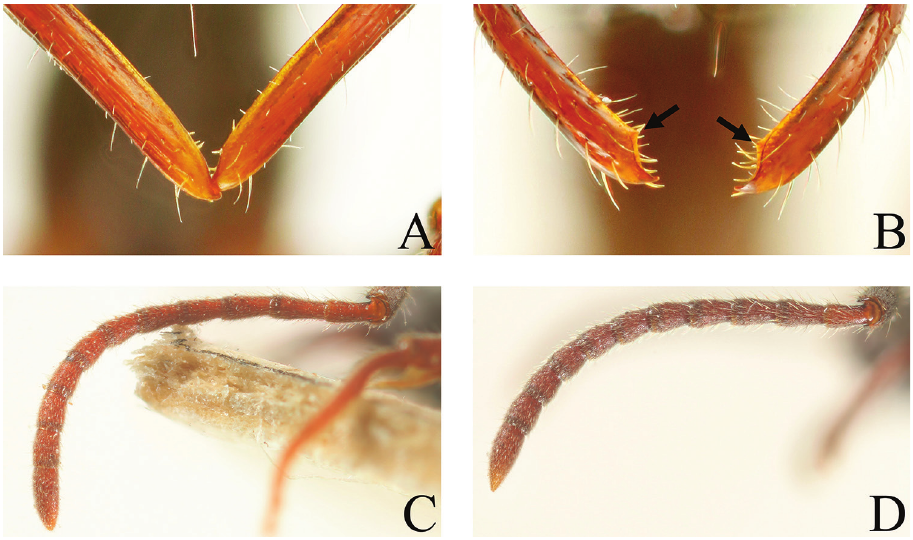
Figure 15. A, B Apex of mandible C, D Antenna. A Leptogenys itoi , subapical tooth absent B L. brevi- loba , subapical tooth present near apical tooth C L. modiglianii , antennoreme III ca. 2.3 times as long as wide D L. breviloba , antennoreme III ca. 1.6 times as long as wide.